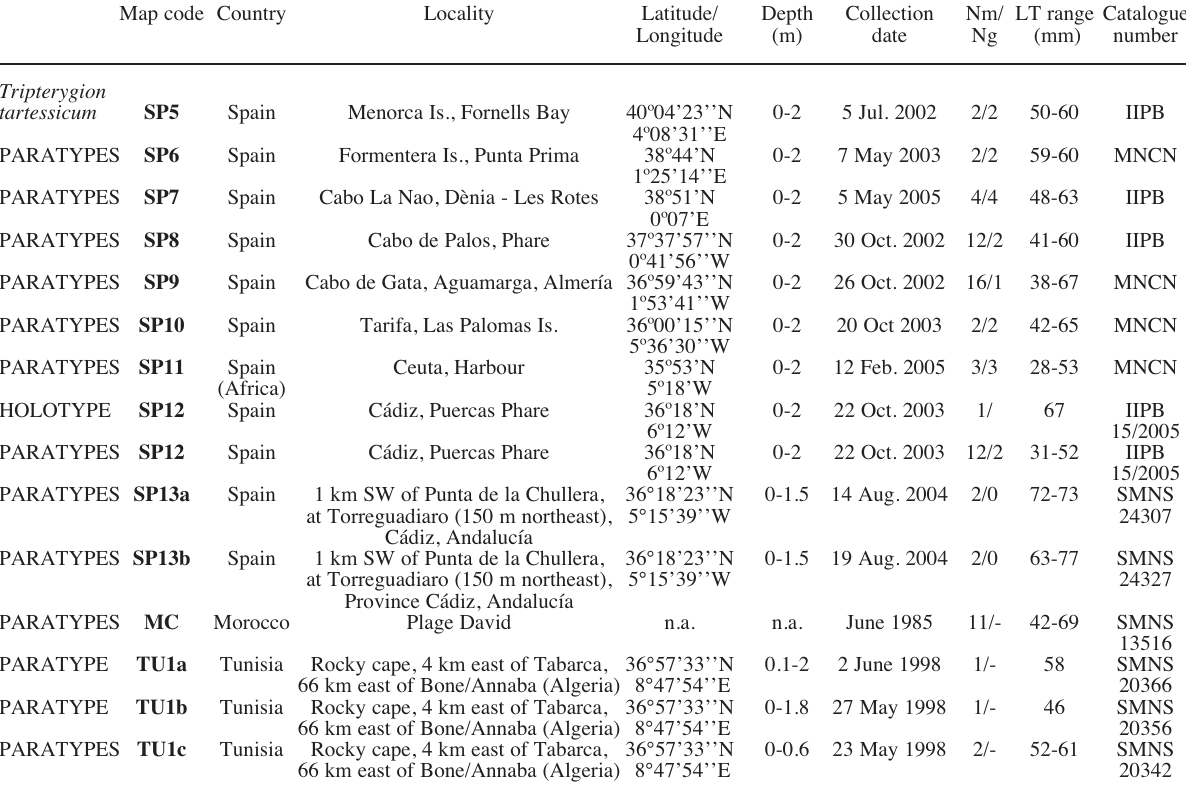
about one-sixth total length. Scales ctenoid, cover- ing entire body except base of pectoral fin and ven- tral abdominal region back to vent. Lateral line hav- ing two sections: anterior section with 20 (19-22) pored scales, posterior section with 22 (21-24) notched scales, having 42 (40-46) in total. Upper, anterior, section commencing at upper angle of opercular opening, slightly curving up over pectoral fin base and running parallel to dorsal profile to point below last 1-3 rays of second dorsal fin; canal running across exposed width of each scale. Lower, posterior, section commencing below, and in front of last scale or two of upper section, running along the mid-line of tail to caudal fin base; each scale with shallow notch in free-edge tip. Three dorsal fins with III + XVI + 13 (III + XVI- XVIII + 12-13) rays. First dorsal fin lower than sec- ond and second higher than third. First just